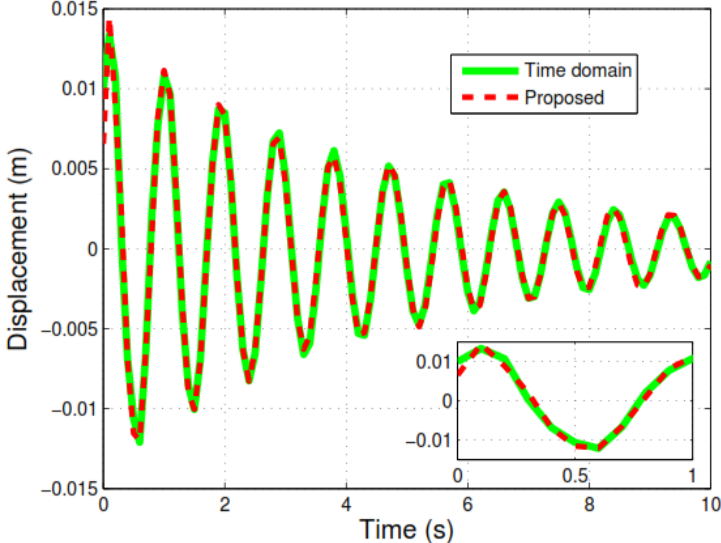
Figure 7. The response comparison at the top of tower in the y direction when external loads, nonzero displacements, and velocity are applied simultaneously.